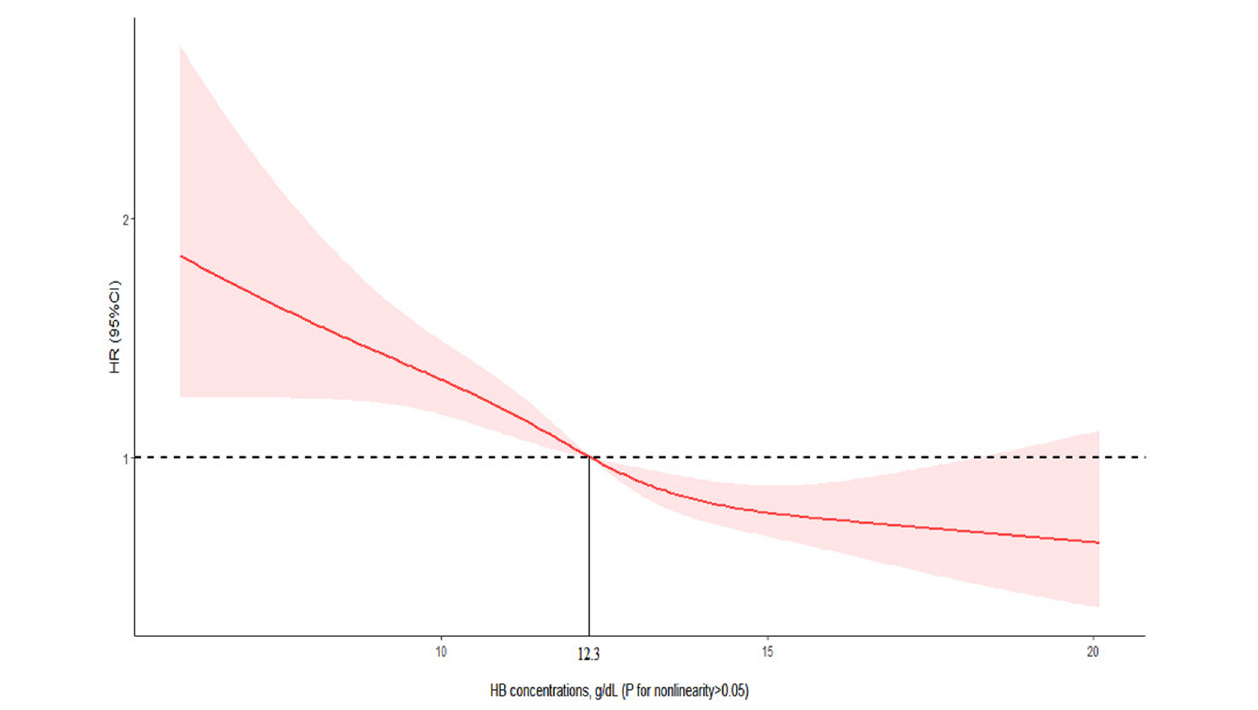
FIGURE 2 | Association of HB with all-cause mortality among the older adults form Chinese longevity regions. Cox models with restricted cubic spline curves adjusted for age, sex, education time, marital status, residence, economic status, smoking status, drinking status, tea drinking, food diversity score, regular exercise, ADL, self-reported diagnosed hypertension, diabetes, stroke, heart disease, MMSE score, depressive symptom score, BMI, CRP, eGFR, WBC count, MCV, platelet count, and TC.